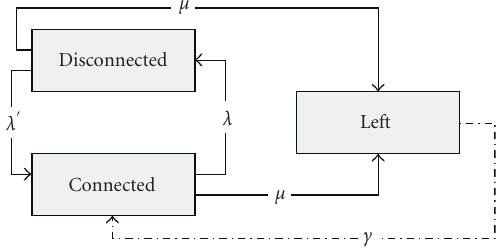
Figure 8: State model of data storage and maintenance.